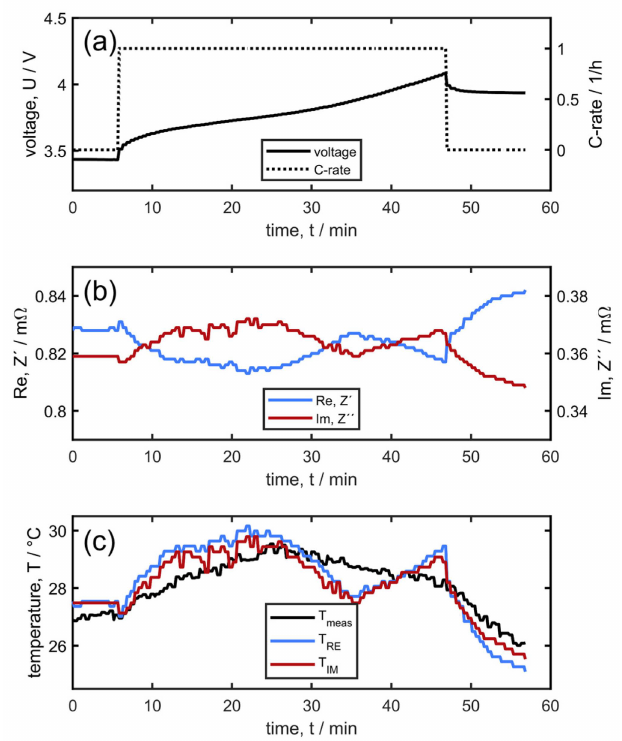
Figure 2. Moderate fast charging with 1C at a 25 ◦ C initial temperature without lithium plating, ( a ) cell potential and current, ( b ) real and imaginary cell impedance measured at 3125 Hz, and ( c ) cell temperatures measured with an external temperature sensor and derived from the cell